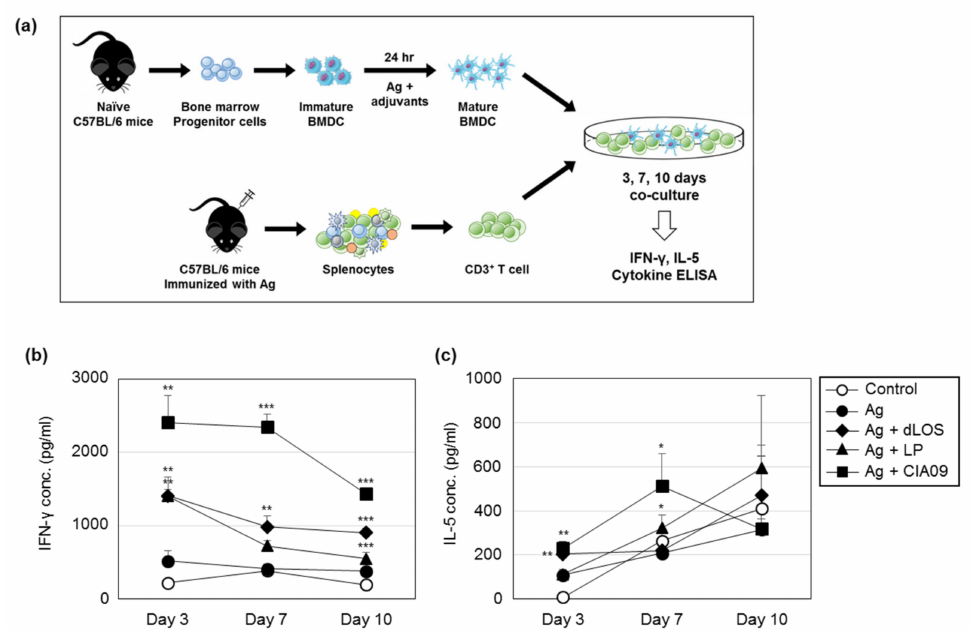
Figure 11. Efficient antigen presentation to T cells by DCs pulsed with CIA09-adjuvanted gE antigen. ( a ) T cells isolated from gE-immunized mice were co-cultured for 24 h with BMDCs that had been pulsed with gE, alone or in combination with dLOS, liposomes (LP), or CIA09. The culture medium was harvested at 3, 7, and 10 days post-treatment and assayed for IFN- γ ( b ) and IL-5 ( c ) by sandwich ELISA. Results are expressed as the mean ± SD of values obtained from triplicate cultures. The data presented are representative of two independent experiments with similar results. * p < 0.05; ** p < 0.01; *** p < 0.001 as compared with antigen-treated